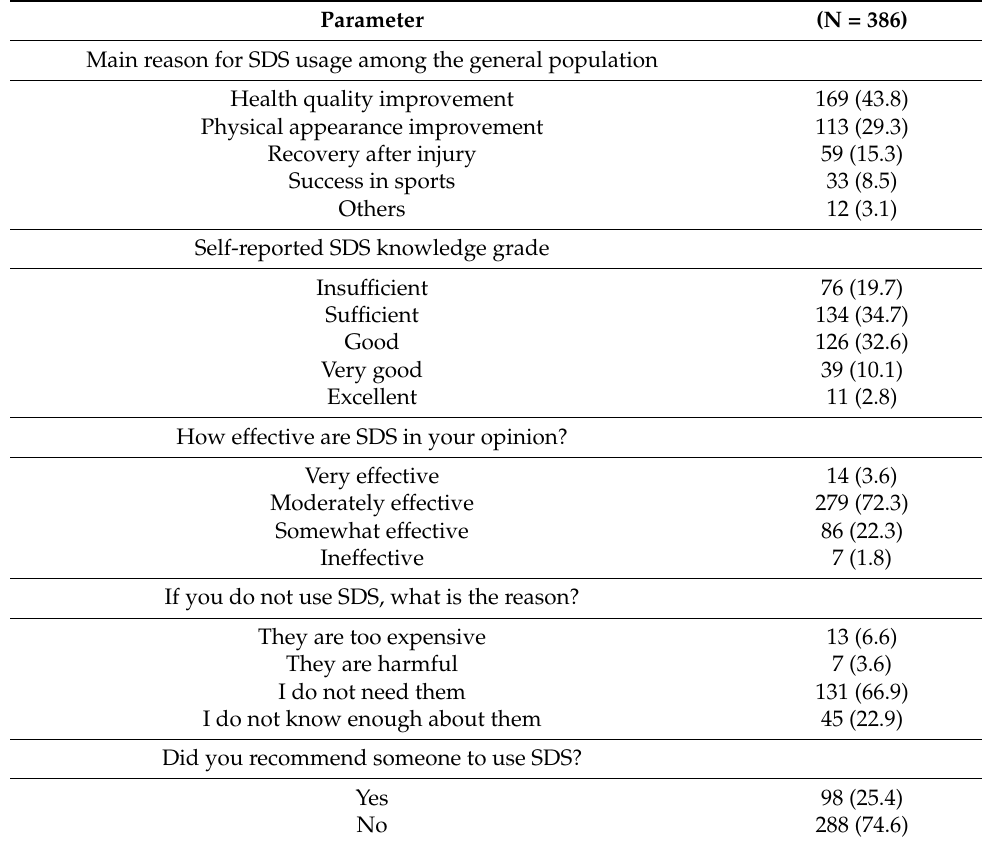
Table 4. Opinions about SDS usage in the study population.